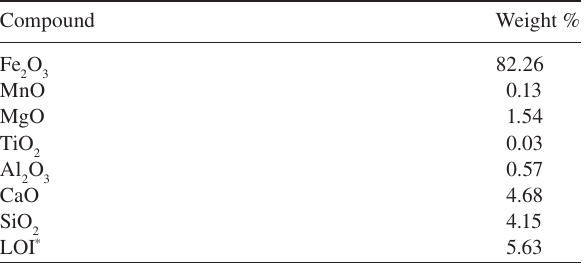
Table 2 C hemical composition of hematite.